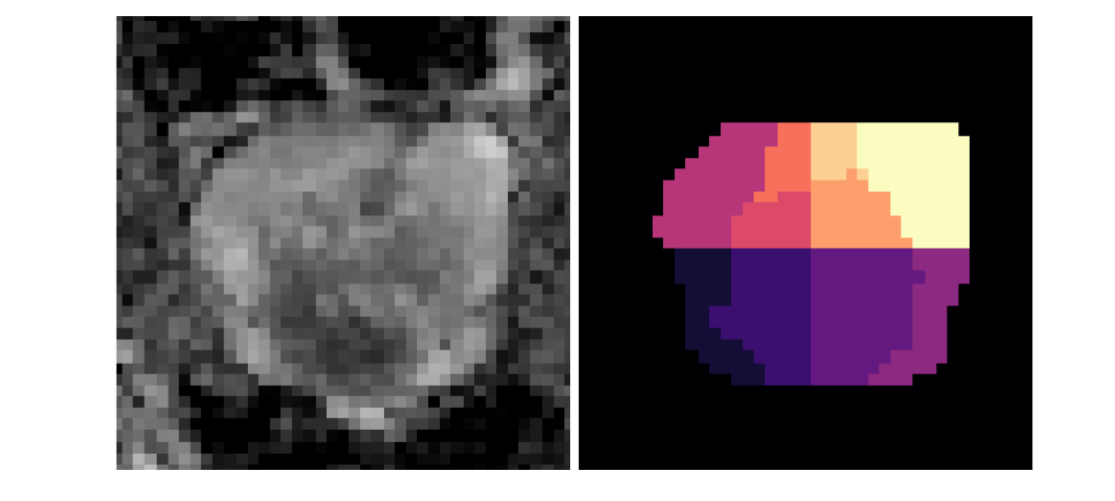
Figure 2. Visualization of the ten anatomical prostate zones used in the study. (left) A prostate slice, (right) the corresponding zone-level